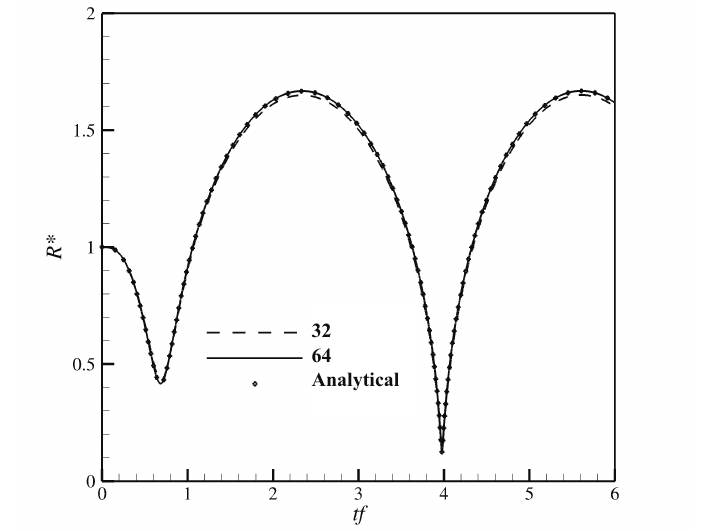
Figure 3. Isolated bubble: The time history of the bubble size R ∗ = R b / R b 0 in 3D